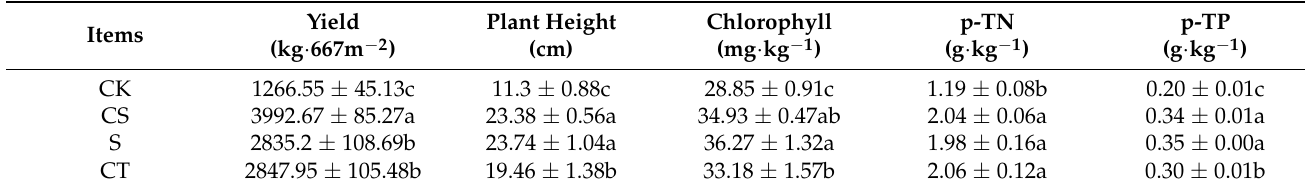
Table 2. The yield and quality of Chinese cabbage under different treatments.